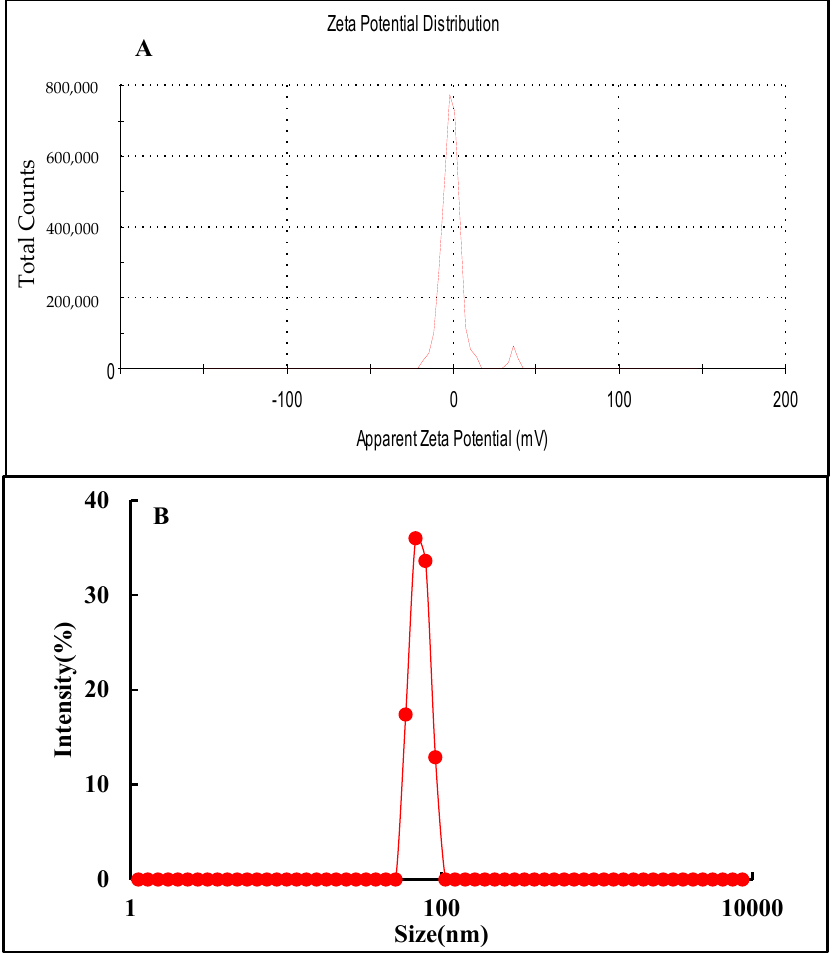
Figure A2. Apparent zeta potential and particle size distribution of DdBd. (A) Apparent zeta potential of DdBd. (B) DdBd particle size distribution.